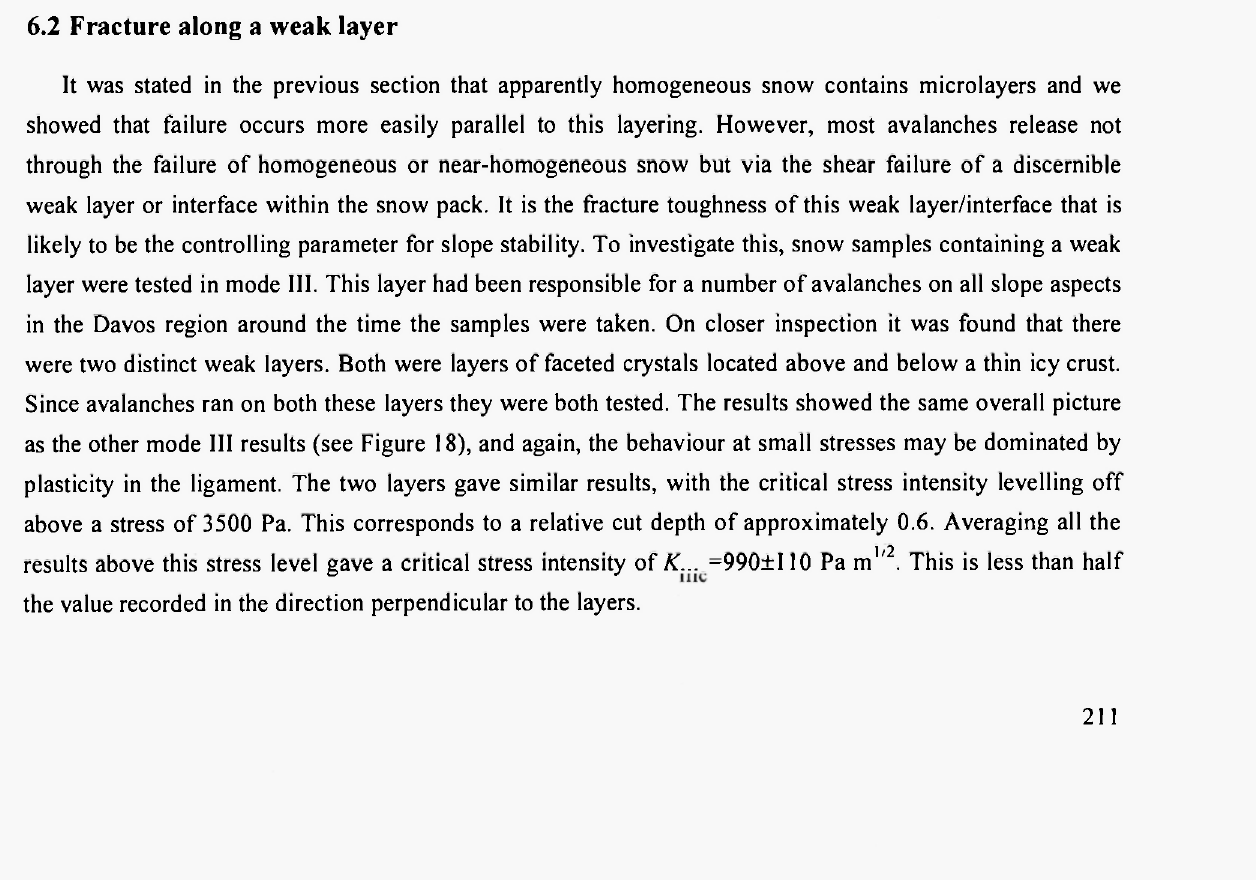
Results of mode III fracture toughness testing on layered snow. By fitting curves to the data the mode III stress intensity parallel to the layers is found to be 75 % of that perpendicular to the